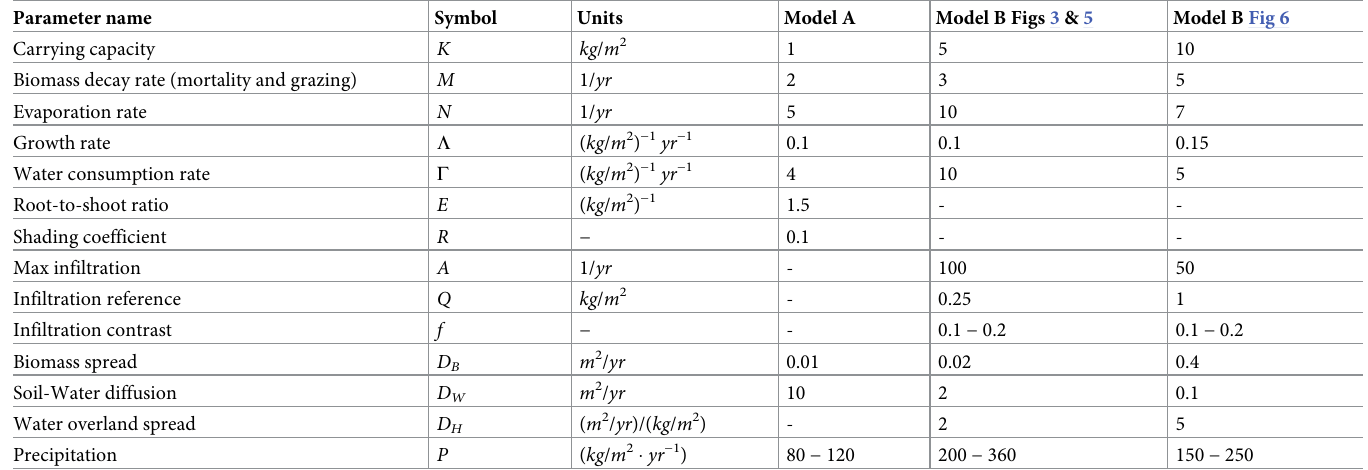
Table 2. Model parameters.